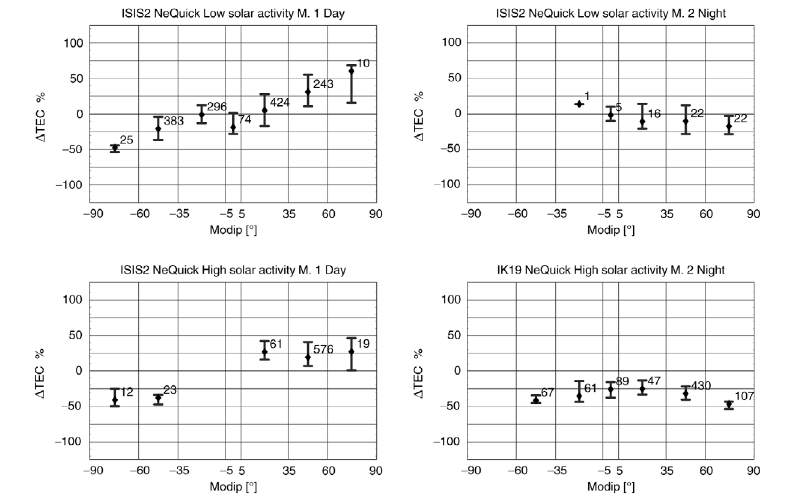
Fig. 3. Percent difference between experimental topside TEC and NeQuick topside TEC for months group 1 and 2. Numbers indicate the amount of data in each